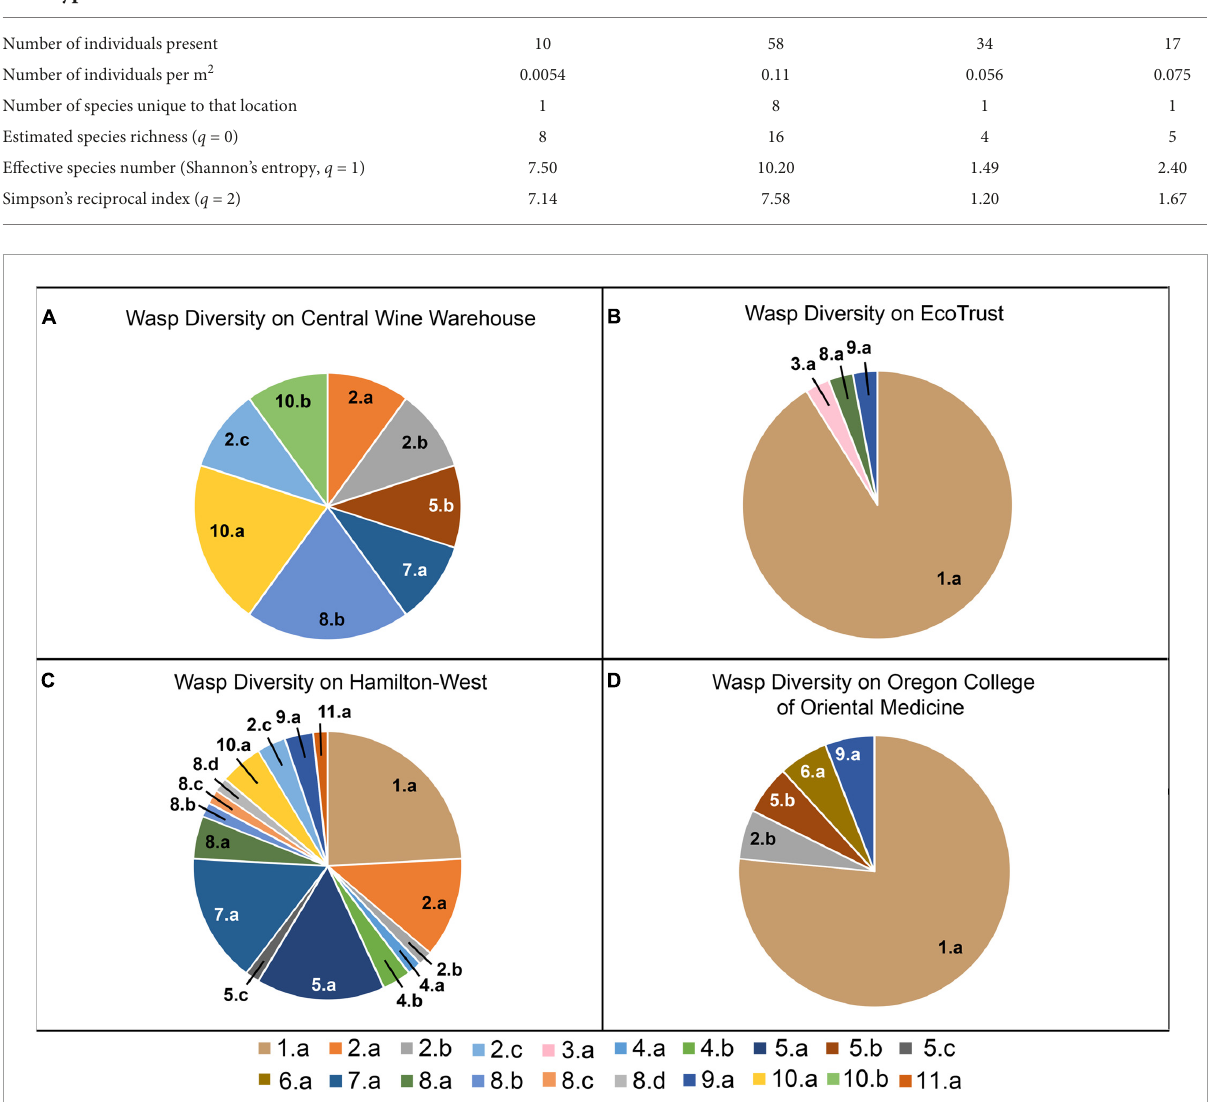
FIGURE3 Composition of Hymenoptera morphospecies collected using pitfall traps during April to June of 2015 on green roof locations in Portland, Oregon: (A) CWW, (B) ET, (C) HW, and (D)